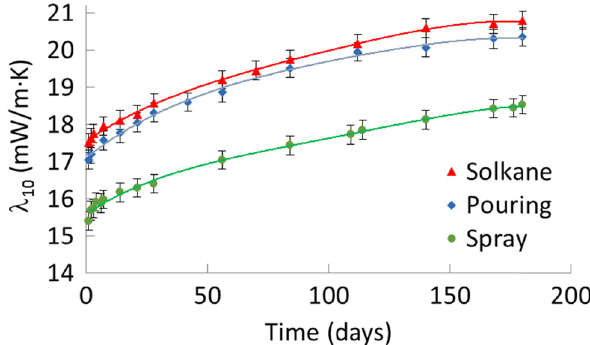
Figure 1: Variation of the thermal conductivity coe ffi cient of pouring and spray foams during